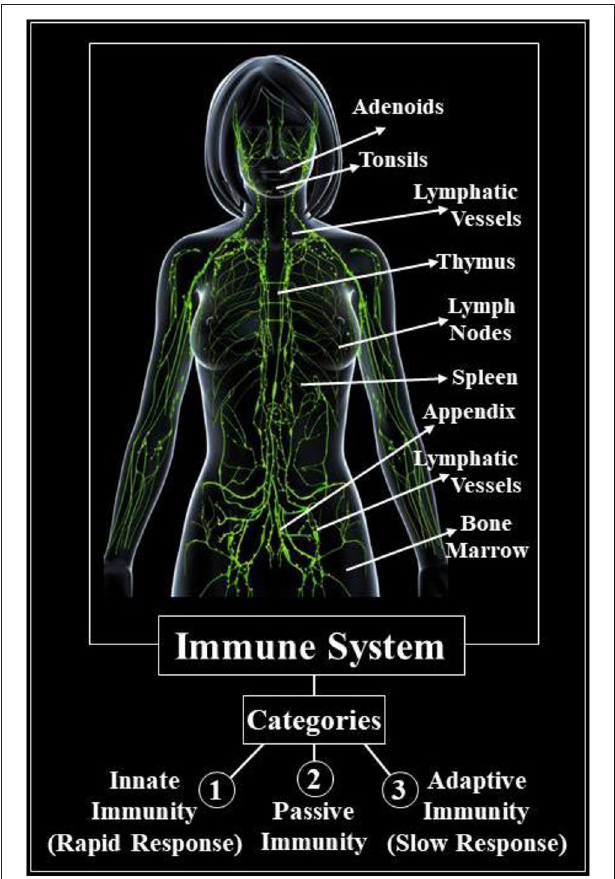
FIGURE 2 | Different categories of the human immune system (28).